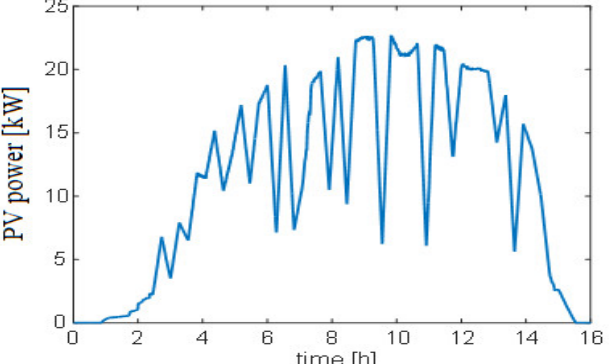
Figure 11. Power of the PV panels in point of coupling.